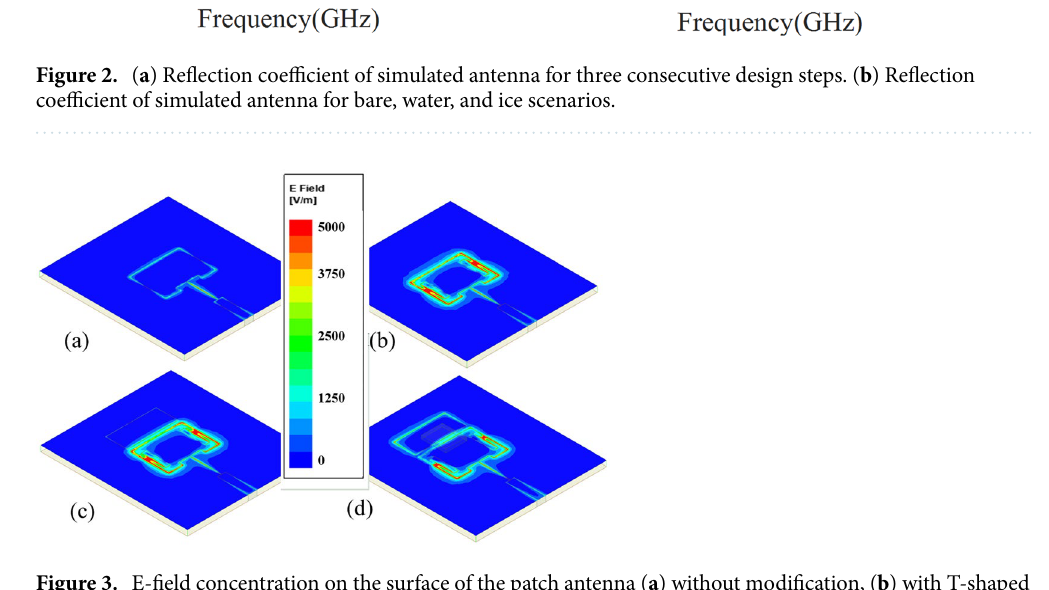
Figure 3. E-field concentration on the surface of the patch antenna ( a ) without modification, ( b ) with T-shaped slots, ( c ) with T-shaped slots and the rectangular slab element, and ( d ) with T-shaped slots, the rectangular slab, and water placed on its